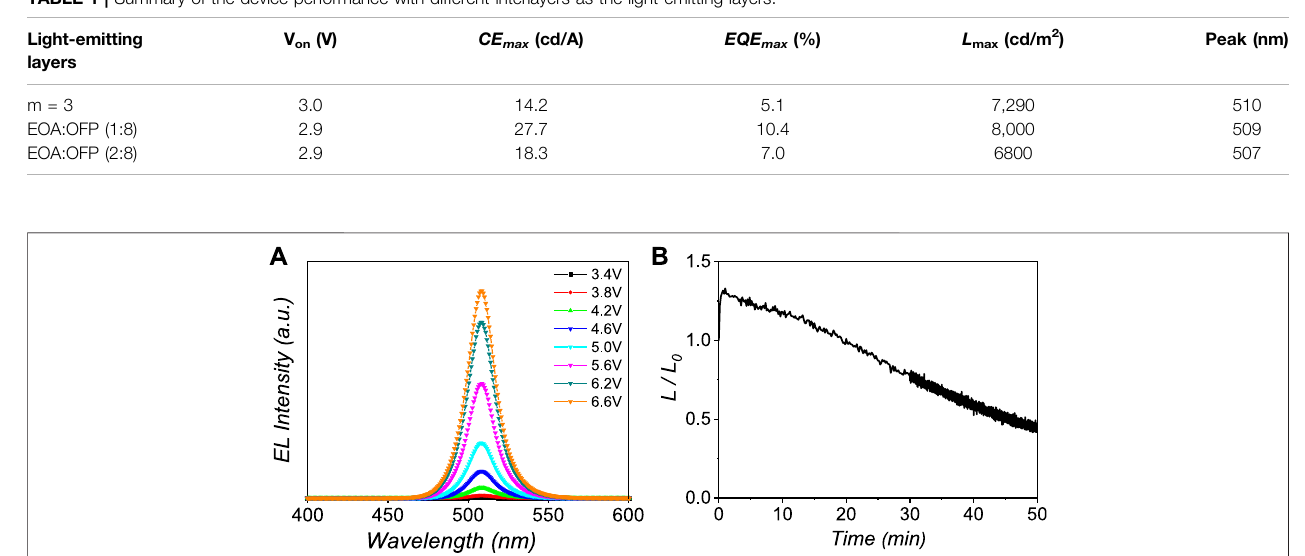
FIGURE4 | (A) EL spectra ofEOA:OFP (1:8) PeLEDs withthe operating voltage from 3.4 to6.6 Vand (B) T 50 lifetimemeasurements for EOA:OFP (1:8) PeLEDs at an initial luminance of 100 cd m − 2 .